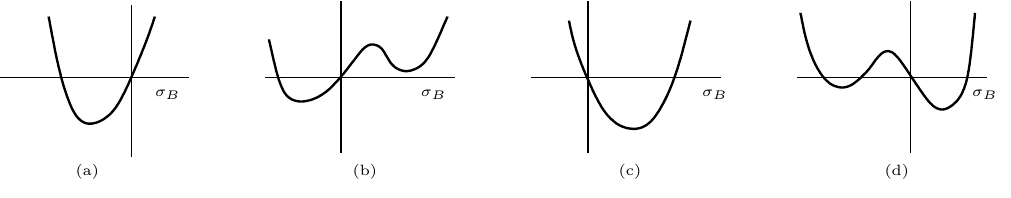
Figure 7 . E(cid:11)ective potential for (cid:30) 1 < x 6 < (cid:30) 2